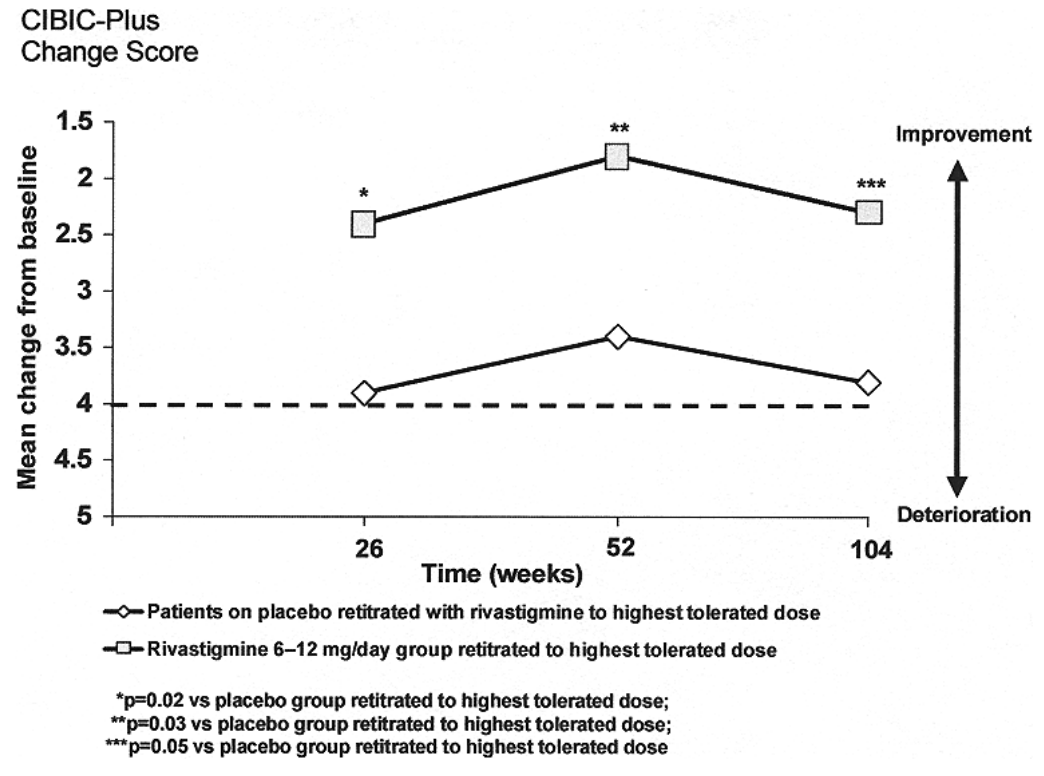
Fig. 2. Mean rating change from baseline in CIBIC-Plus behavioural